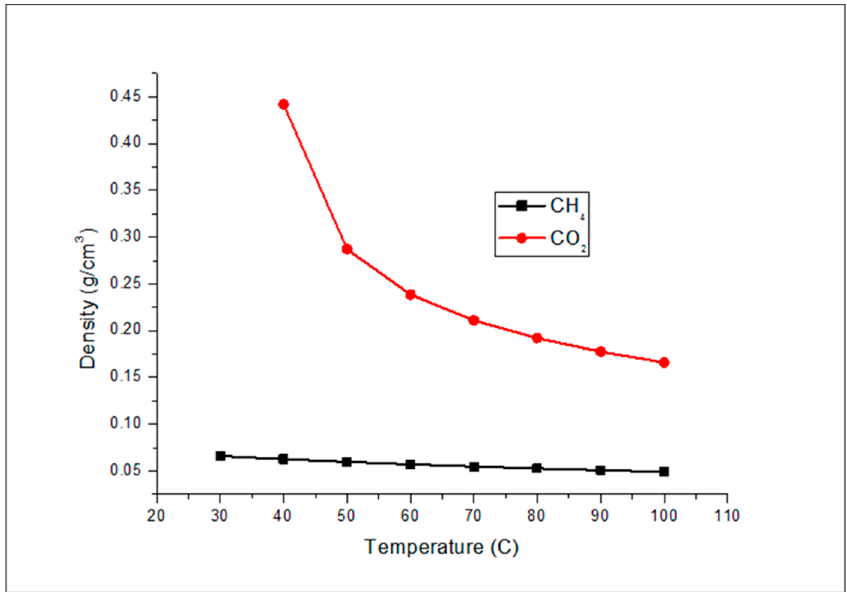
Figure 1. CH 4 and CO 2 density as a function of temperature at 1300 psi.